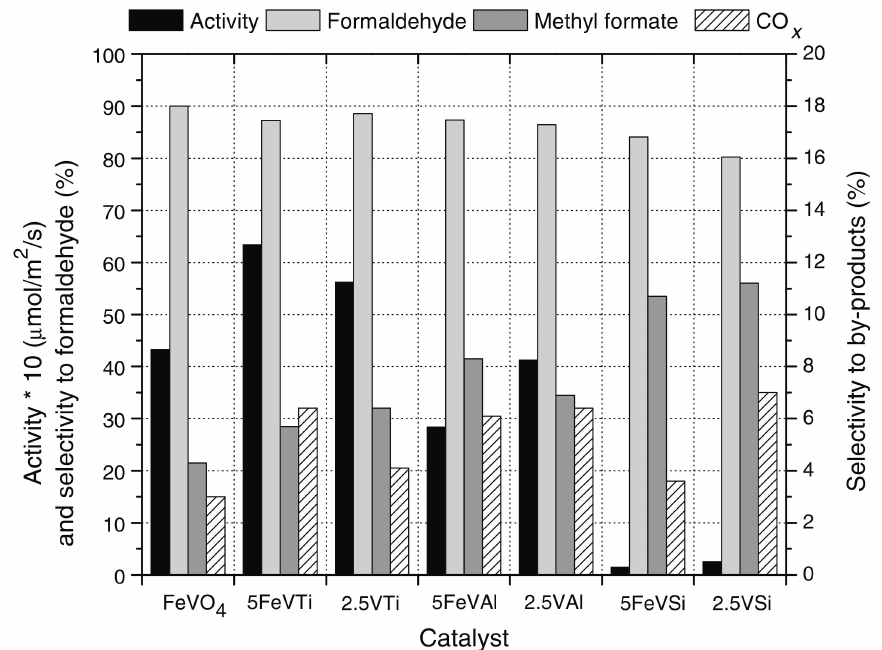
Figure 37. Activity and selectivity of FeVO 4 and supported layers of FeV and V (5FeV = 5 theoretical layers of FeV; 2.5V = 2.5 theoretical layers) on TiO 2 , α -Al 2 O 3 , and SiO 2 . T = 300 ◦ C. Composition: 10 vol.% MeOH and 10 vol.% O 2 in N 2 . Conversion of 80%. Activities were measured at low conver- sions. Reprinted with permission from [214] Springer Science+Bussiness Media. Copyright ©